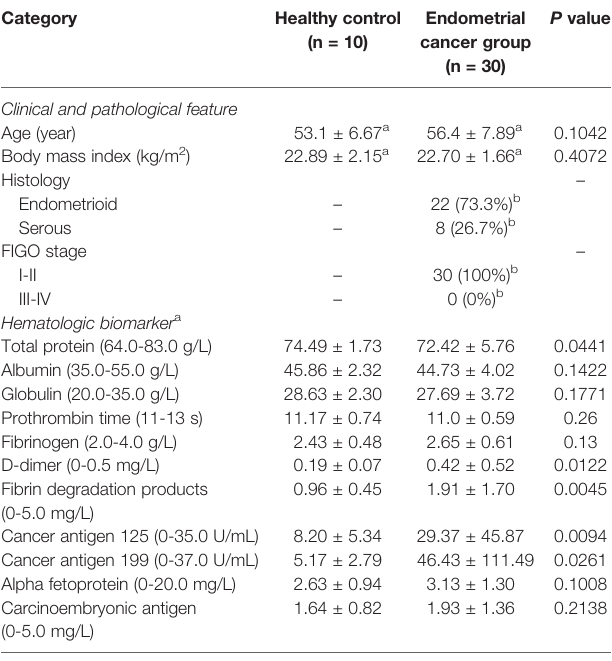
TABLE 1 | Clinical characteristics summary of all enrolled women. Category Healthy control (n = 10)